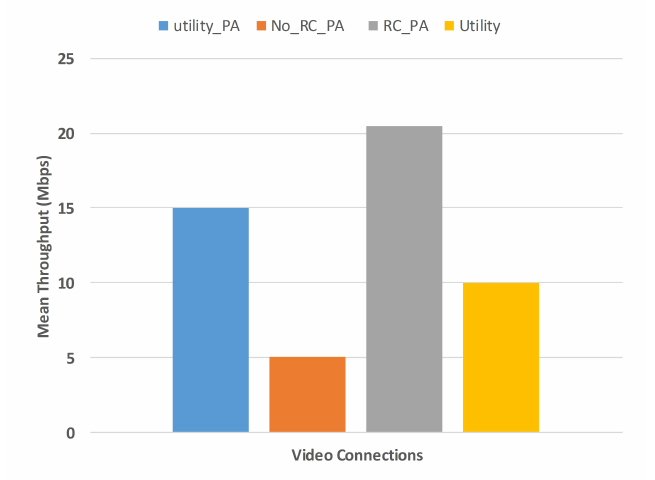
Figure 3. Throughput of the video traffic.